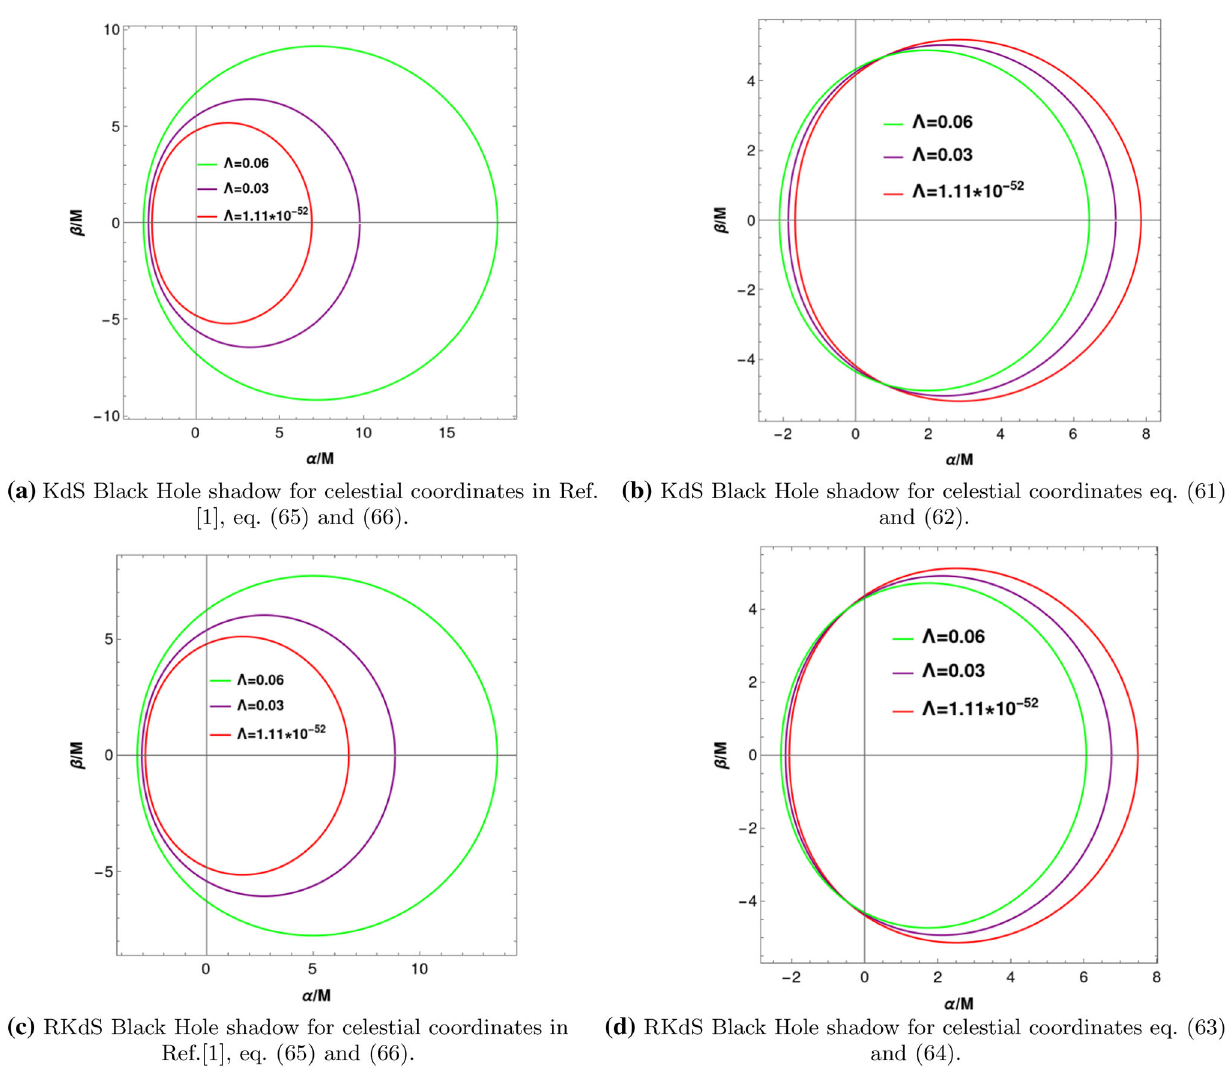
Fig. 6 Comparison of the shadows for impact parameter used in Ref. [1] with those that we obtain. For fixed a = 0 . 999, M = 1 . 06, θ = π/ 2, a = 0 . 999 and different values of